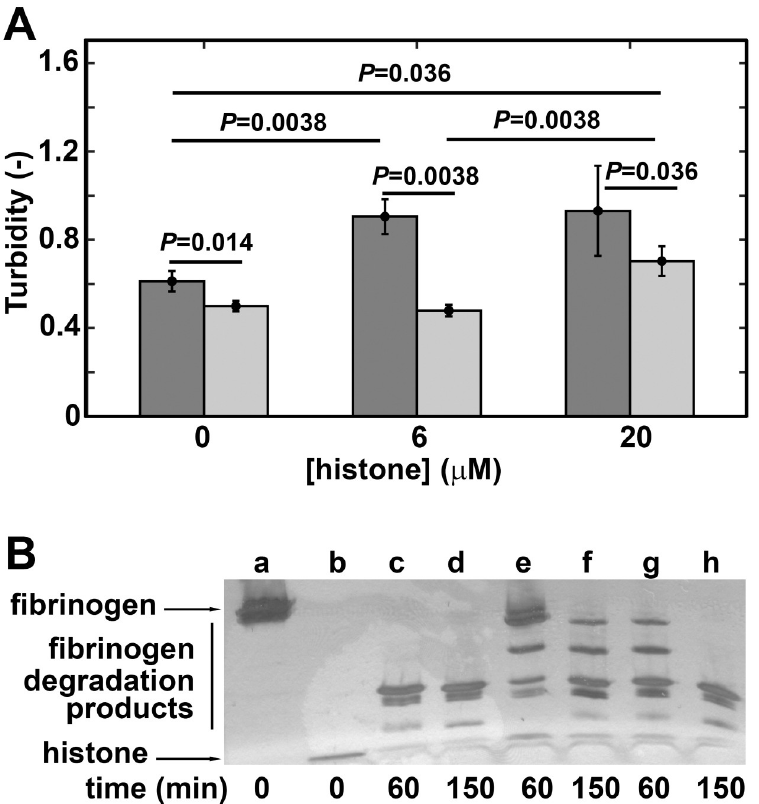
Fig 5. Histone-fibrinogen aggregation and its effect on fibrinogen digestion by plasmin. Fibrinogen solution (7 μ M) was added to histone (0, 6 or 20 μ M) in the absence (black bars in panel A , a-b lanes in panel B ) or presence (grey bars in panel A , c-h lanes of panel B ) of plasmin (50 nM). Panel A : Aggregation was monitored by turbidimetry for 150 min. Mean maximal turbidity ± SD and P -values according to Kolmogorov-Smirnov test for differences between the indicated pairs of datasets are shown (n = 15). Panel B : Digestion of fibrinogen-histone mixtures by plasmin. Non-reducing samples were taken for SDS-PAGE at 0, 60 or 150 min and electrophoresis was performed on a 4–15% polyacrylamide gel followed by silver staining. Panel B : a , c , d : Fibrinogen; b : Histone (20 μ M); e , f : Fibrinogen + histone (20 μ M); g , h : Fibrinogen + histone (6 μ M).